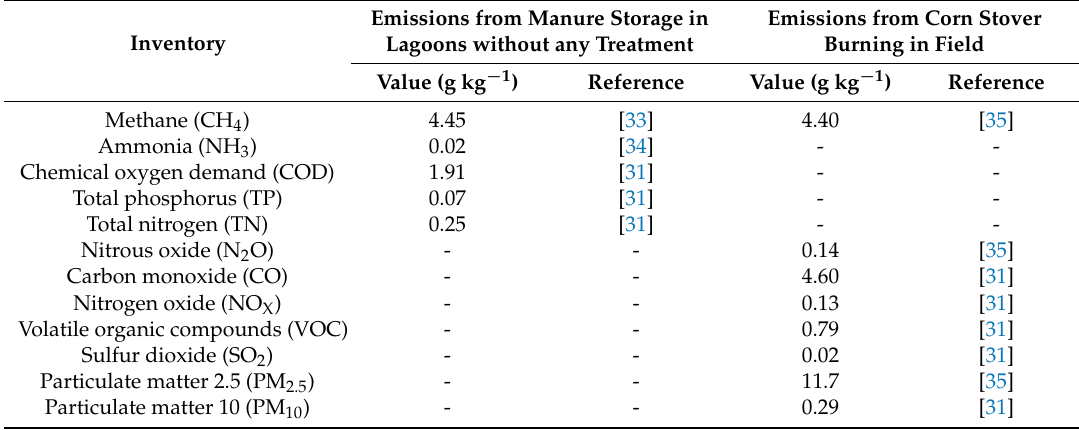
Table 2. The inventory of environmental emissions from manure storage in lagoons without any treatment and corn stover burning in field.